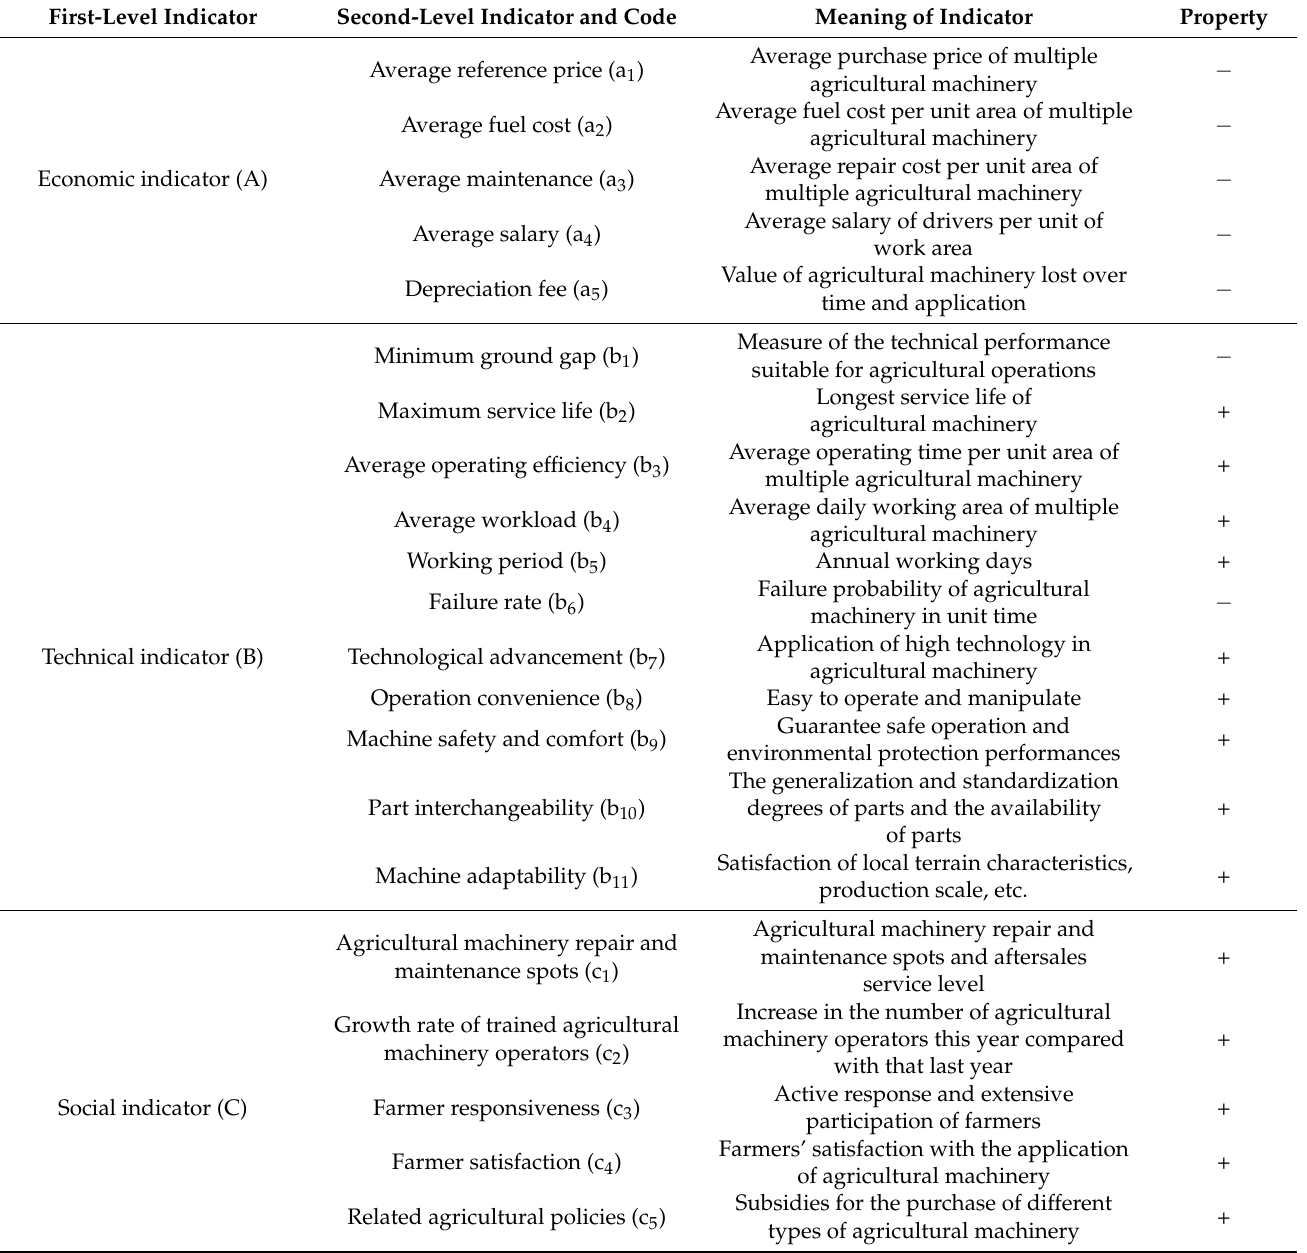
Table 1. Pre-selection index set for the selection of agricultural